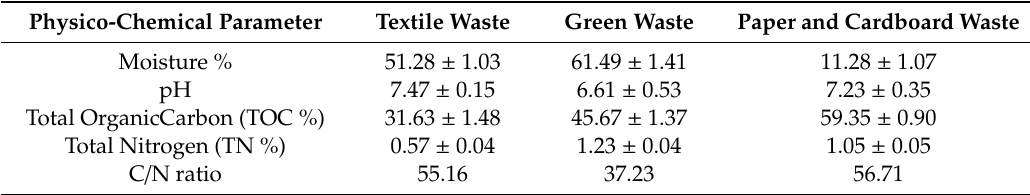
Table 1. Physico-chemical characterization of feedstock (textile waste, green waste, and paper and cardboard